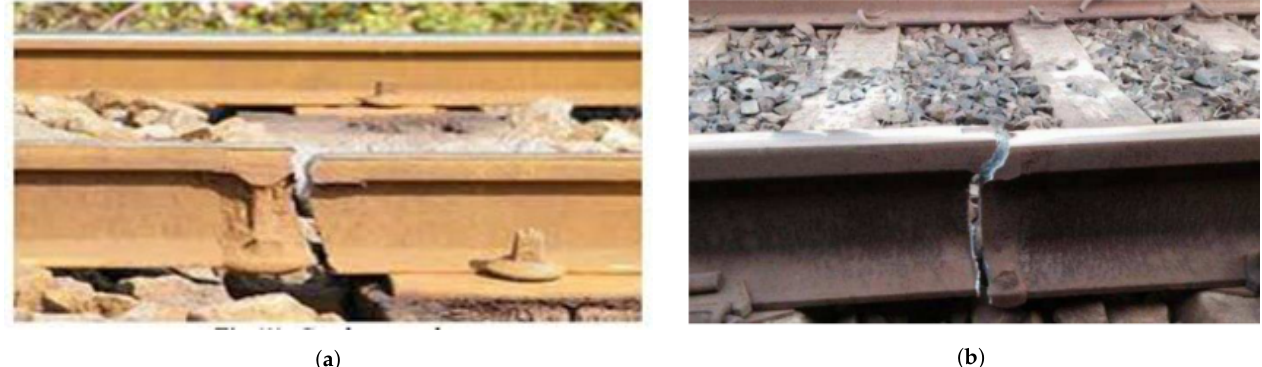
Figure 1. Samples of faults on railway tracks, ( a ) Destroyed patch [7]; ( b ) Partial crack [8]. Such faults can happen due to excessive loads, and the influence of cold and hot weather.